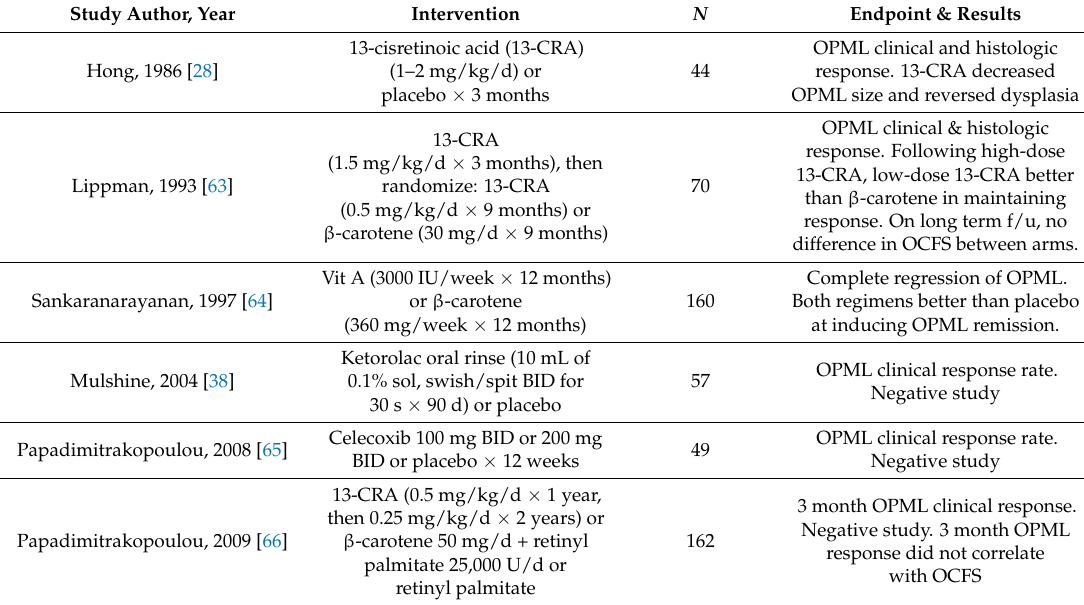
Randomized controlled squamous cell cancers of the head and neck (SCCHN) chemoprevention trials for patients with oral premalignant lesions